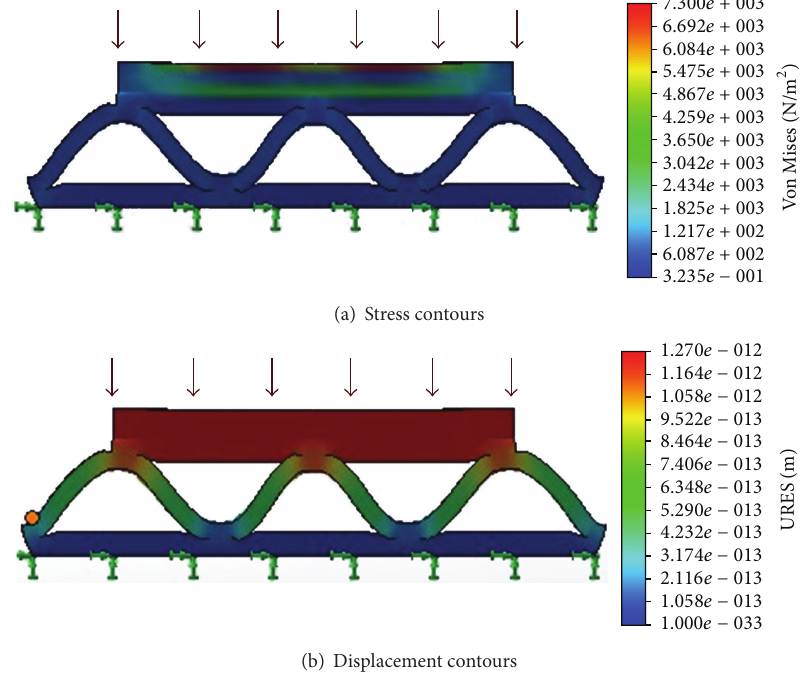
Figure 5: The stress and displacement contours of models of corrugated board with three flutes.